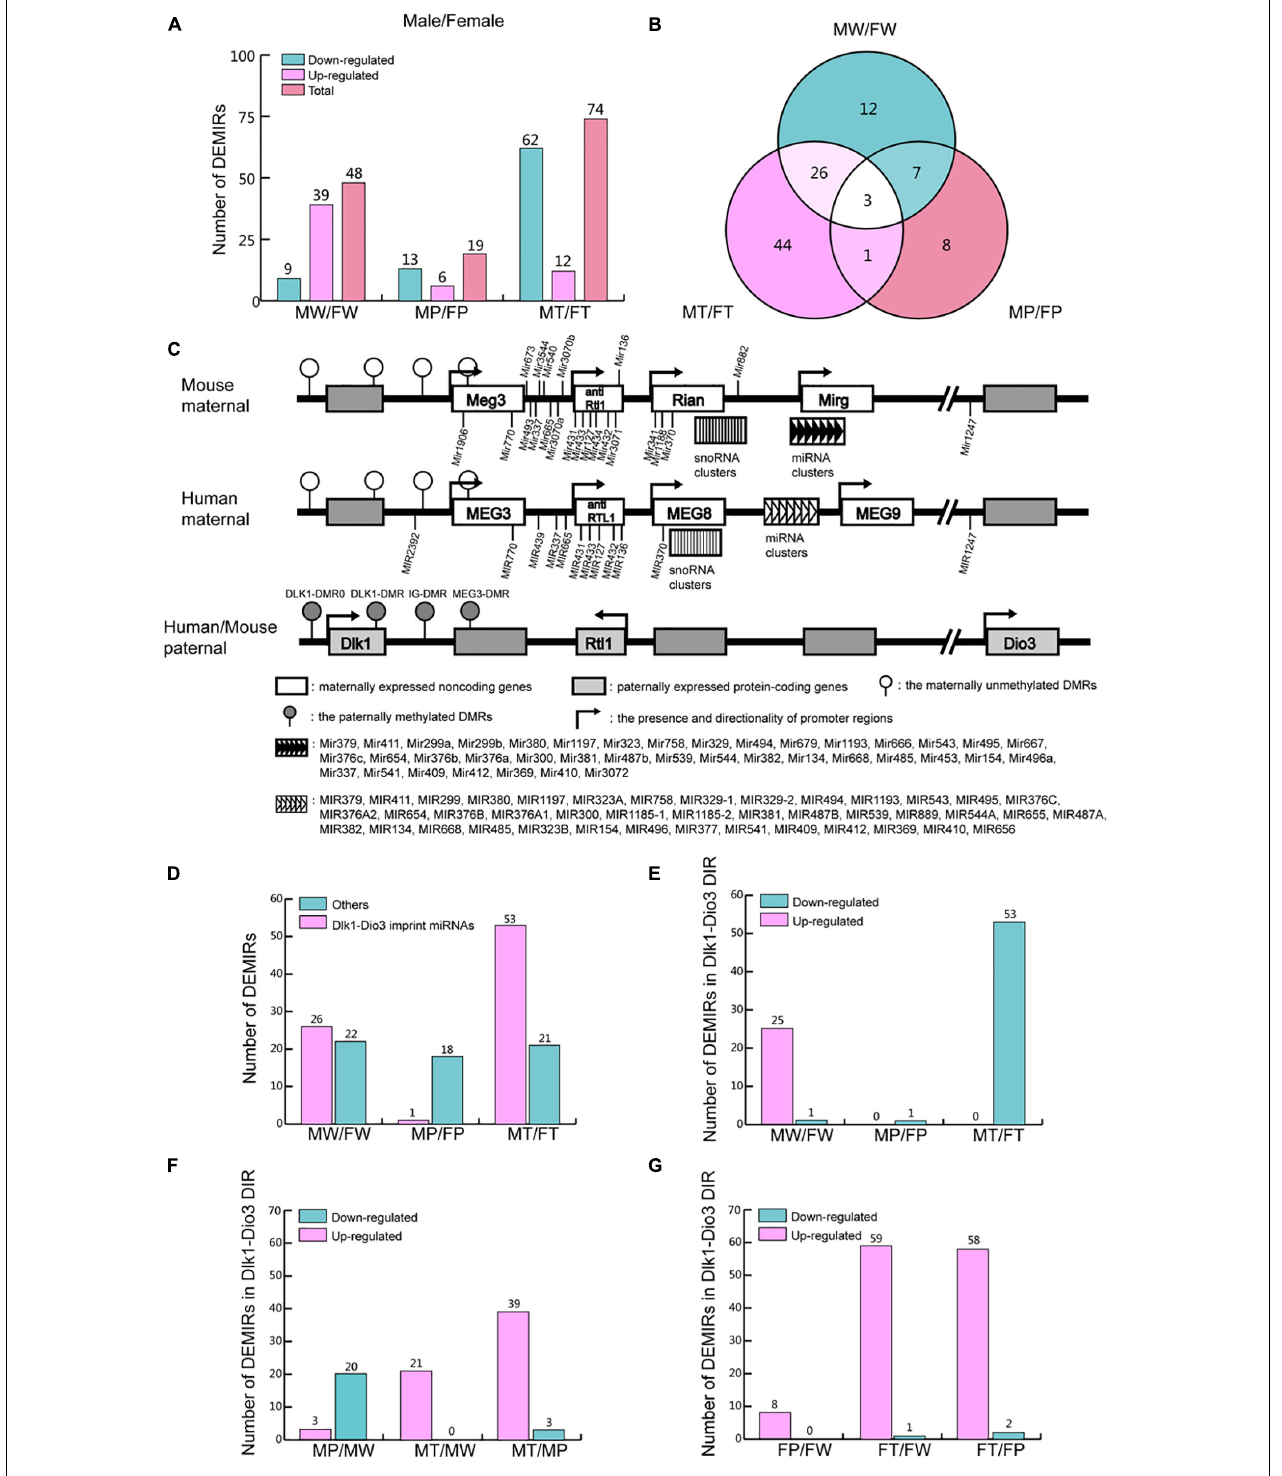
FIGURE 5 | DEMIRs between sexes in the process of hepatocarcinogenesis. (A) The number of up- and down-regulated miRNAs in the comparisons in MW/FW, MP/FP, and MT/FT between sexes. (B) Venn analysis of DEMIRs in panel (A) . (C) Comparative structure model of Dlk1-Dio3 genomic imprinting region (GIR) between human and mice. (D) The number of DEMIRs located in and beyond Dlk1-Dio3 GIR. (E) The number of up- and down-regulated miRNAs located on Dlk1-Dio3 GIR between sexes. (F) The number of up- and down-regulated miRNAs located on Dlk1-Dio3 GIR in males. (G) The number of up- and down-regulated miRNAs located on Dlk1-Dio3 GIR in